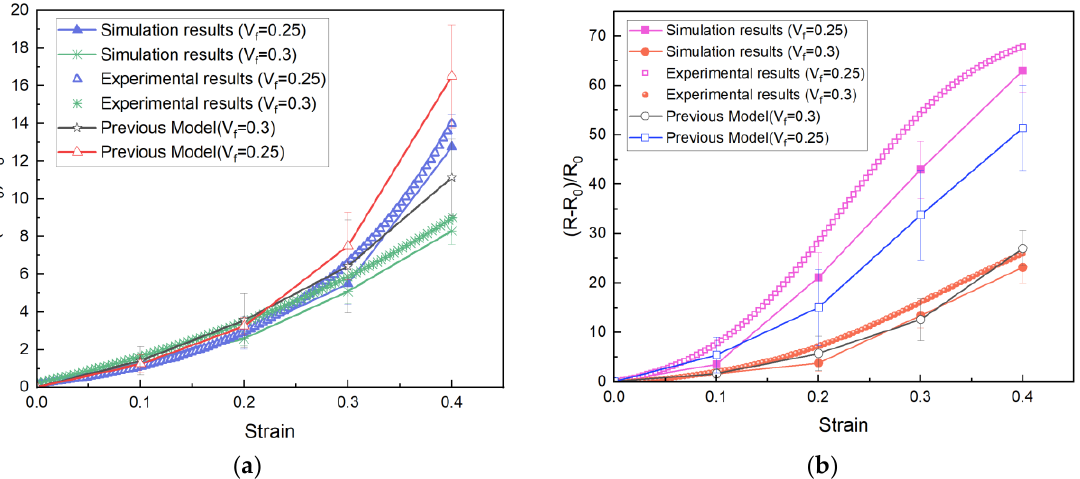
Figure 12. Comparison of the predicted results and the experimental results: ( a ) Silicone elastomer filled with EC − 600JD CNPs; ( b ) Silicone elastomer filled with EC − 300J CNPs.